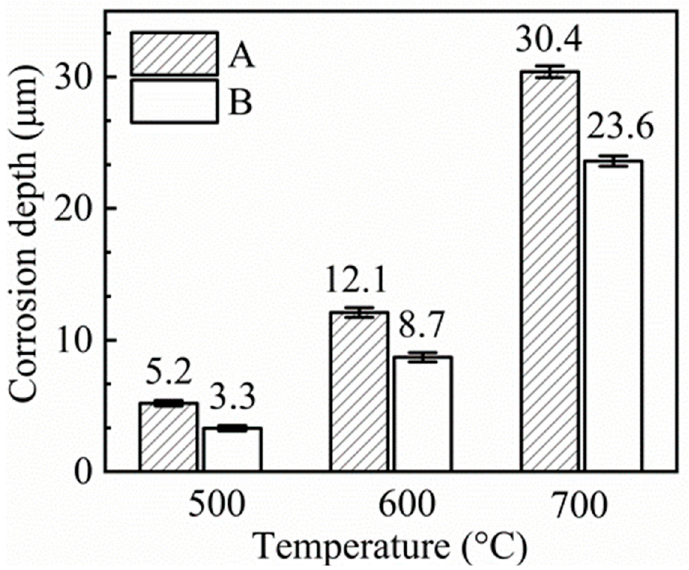
Figure 6. Cr depletion depths of corroded 316SS exposed in salts A and B under Ar for 100 h at 500 °C, 600 °C, and 700 °C.